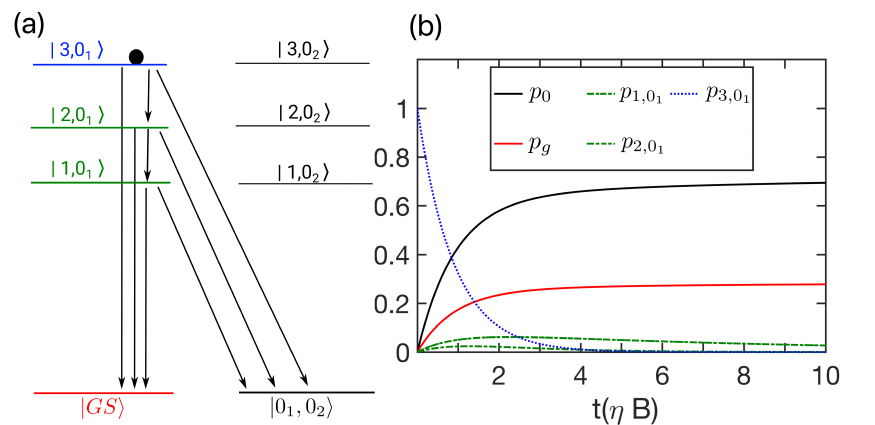
Figure 9: (a) Schematic decay paths in the even parity subspace in an open chain for the initial even state | 3,0 〉 (or towards lower energy states E or | 0 ,0 1 2 different states in the even parity subspace as a function of time for J ( 2 ) for N = 40